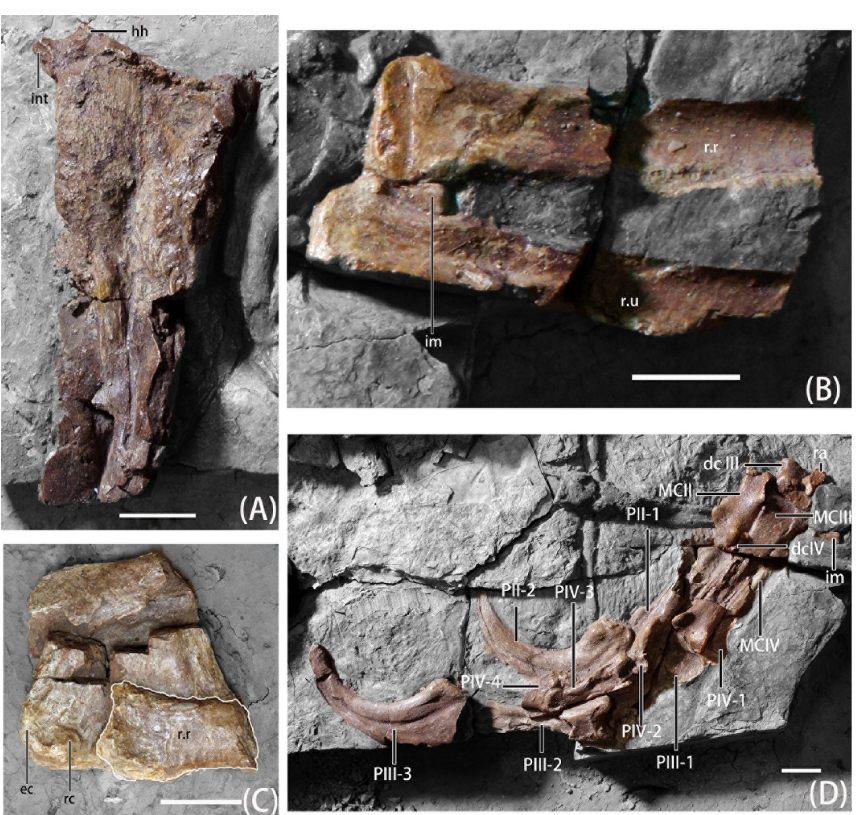
Fig 6. Photographs of right forelimb elements of B . inexpectus (IVPP V 11559) A. humerus in anterior view; B. radius and ulna; C. humerus distal end with radius; D. carpus and manus elements. Abbreviations: dc III-IV , distal carpal III-IV; ec , ectepicondyle; hh , humeral head; im, intermedium; int , internal tuberosity; MCII-IV , metacarpus II-IV; PII-1 to PIV-4 , phalanges II-1 to IV-4; ra , radiale; r.r , right radius; r.u , right ulna; rc , radial condyles. Scale bars equal 2